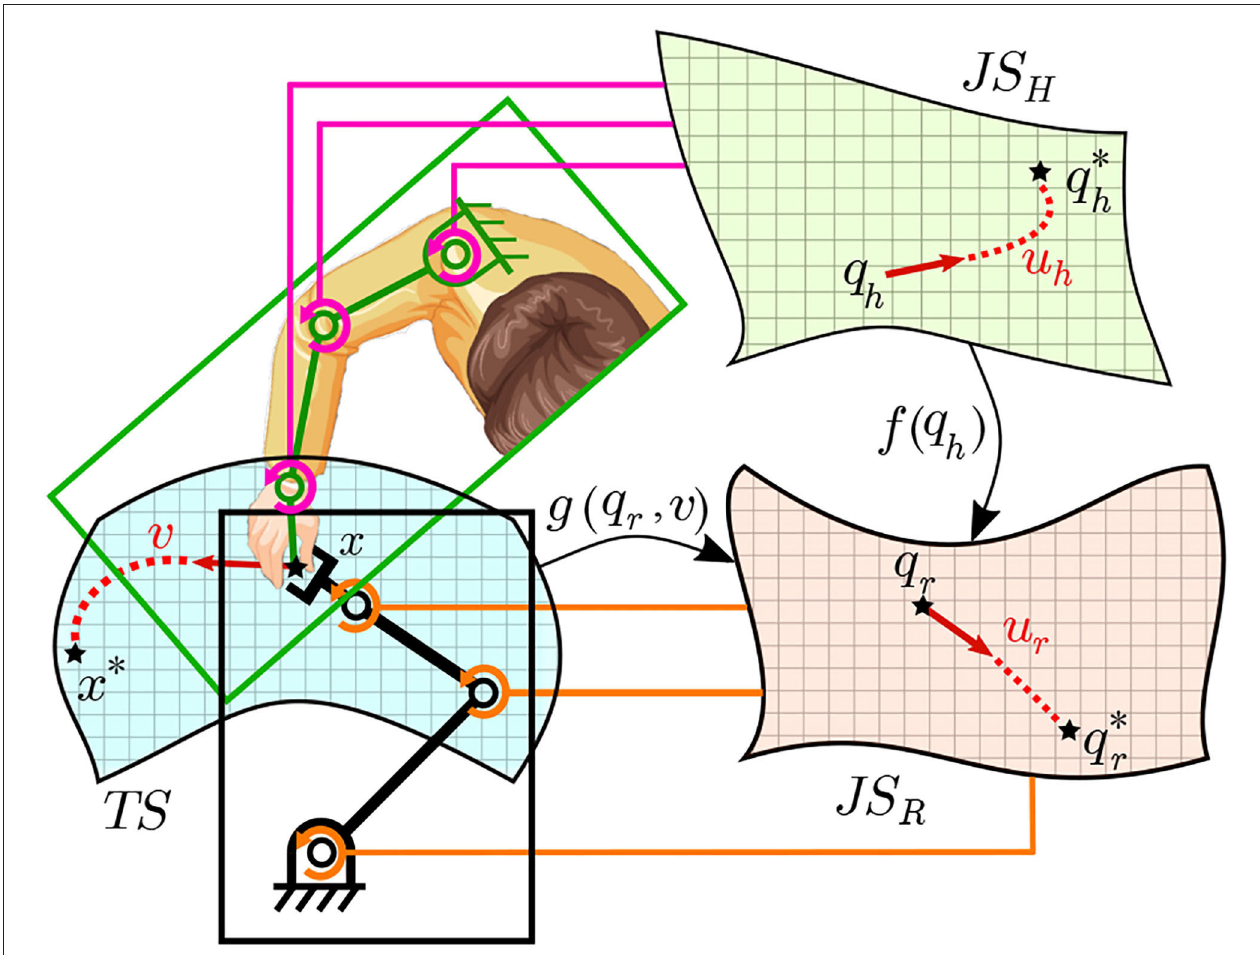
FIGURE 6 | A schematic diagram of the correspondence of the human and robot joint spaces along with the task space TS . The data collected from the human and robot together allows building correlation (i.e., f ( q h ) between JS H and JS R ). This allows generating more examples to train the map g ( q r , v ) correlating TS to JS R by transforming examples conducted by the human arm (in TS ) into JS R